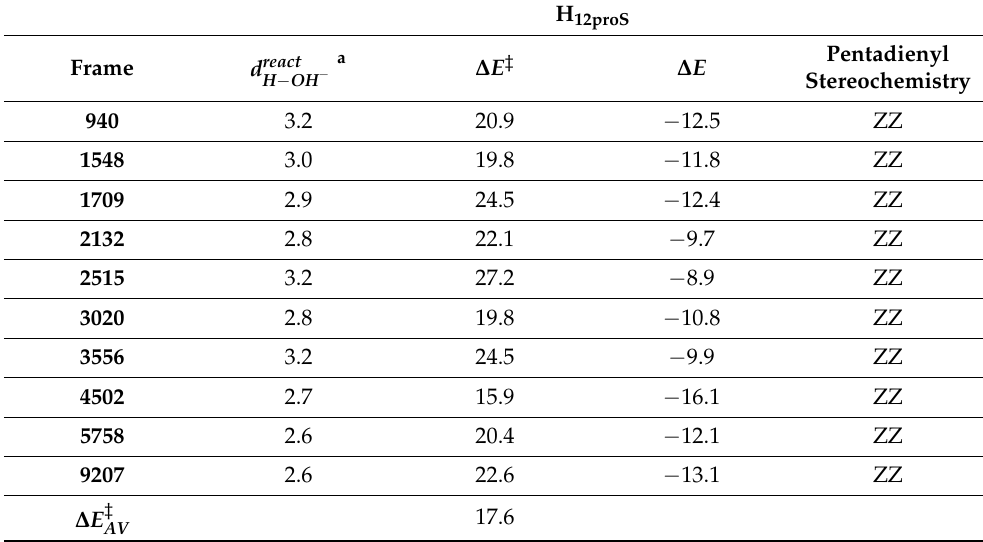
Table 3. Optimized H 12proS -OH − distances (in Å) at reactants, potential energy barriers, and reaction energies (in kcal/mol) for the H 12proS abstraction process. The stereochemistry of the pentadienyl group around C 12 at the product radical is also given. The exponential average potential energy barrier [46] (in kcal/mol) for the H 12proS -abstraction is included in the last row. H 12proS a ∆ E ‡ ∆ E Frame d react H − OH −